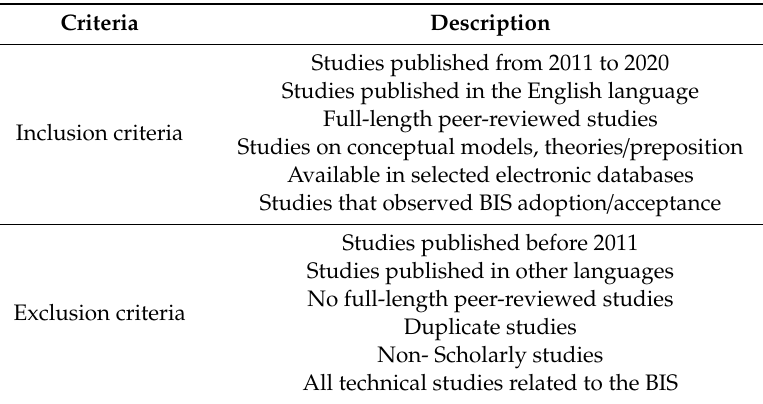
Table 2. Inclusion and exclusion criteria for systematic literature review (SLR).